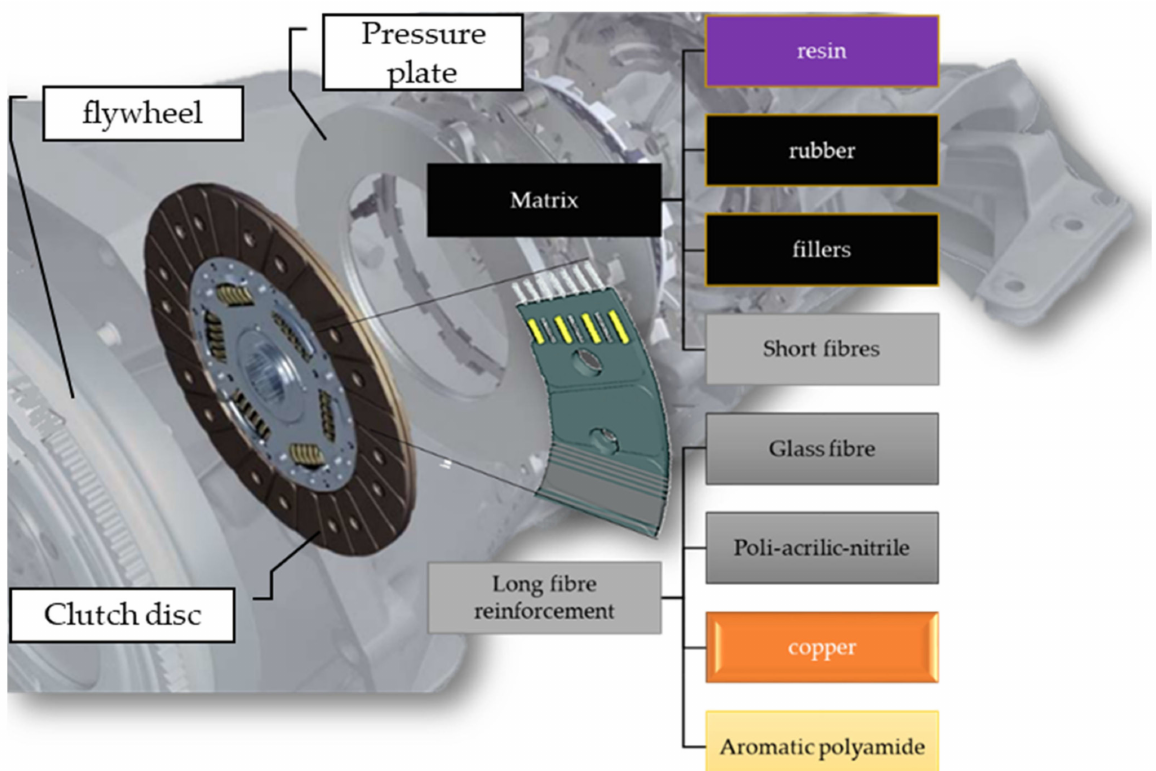
Figure 2. Components of the facing examined in our studies and its location in the